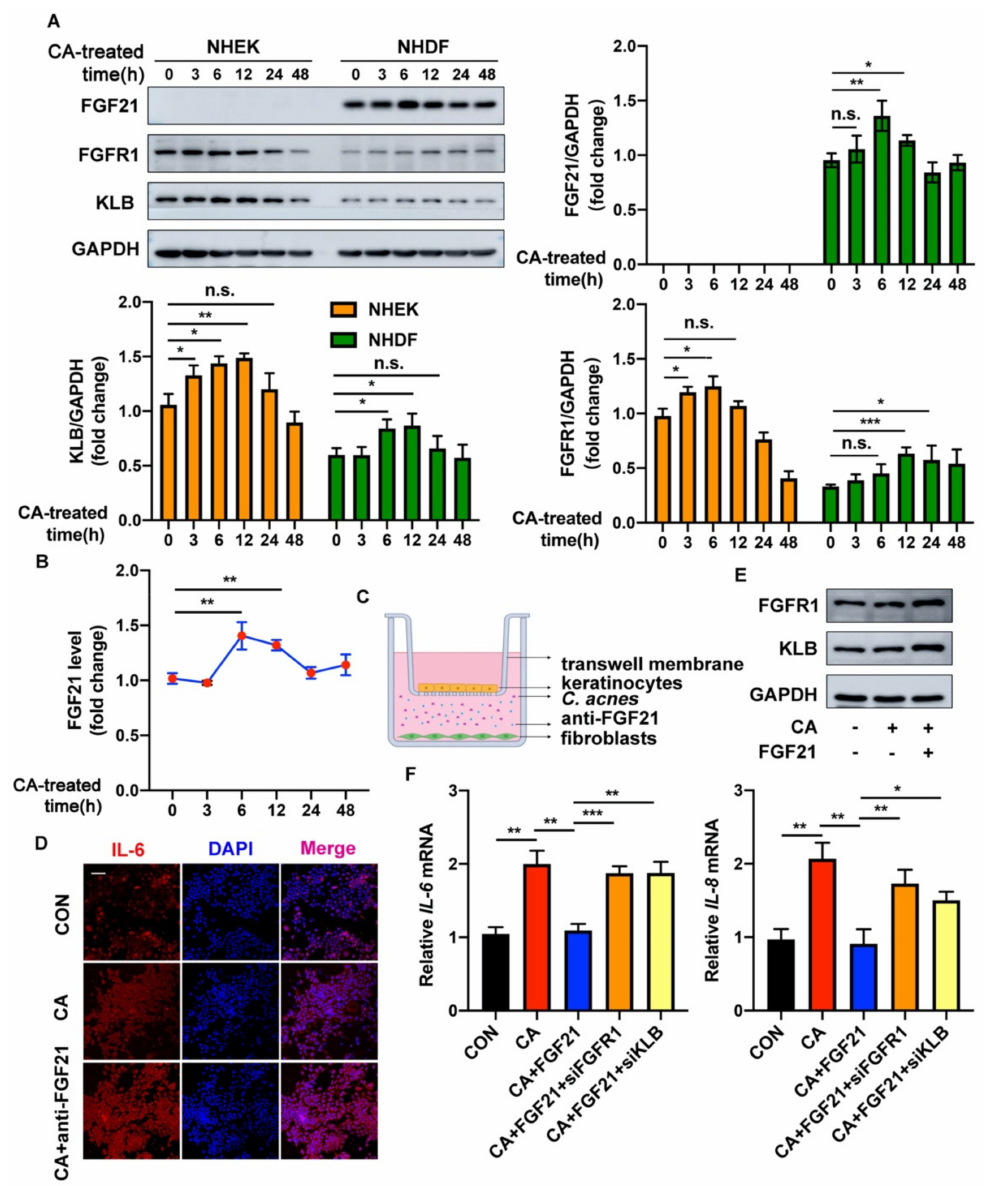
findings show that FGF21 is primarily secreted by NHDFs but not by NHEKs.